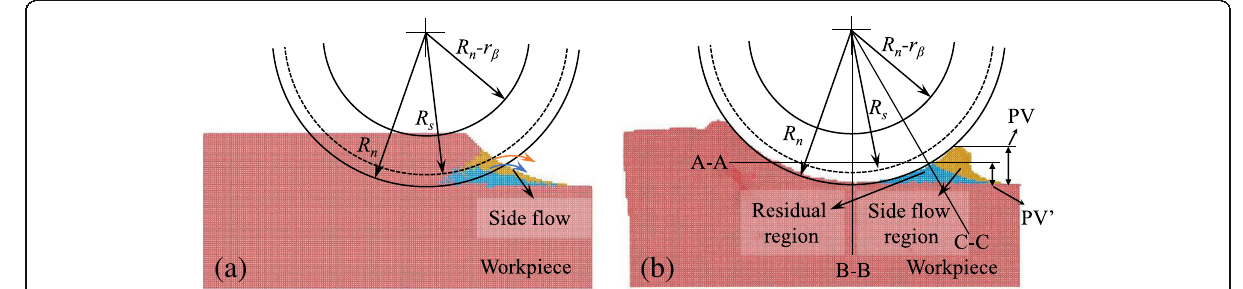
Fig. 4 Atoms tend to form the side flow region ( yellow ) and residual region ( blue ), ( a ) before and ( b ) after nano-cutting in {100} < 001 > cutting direction